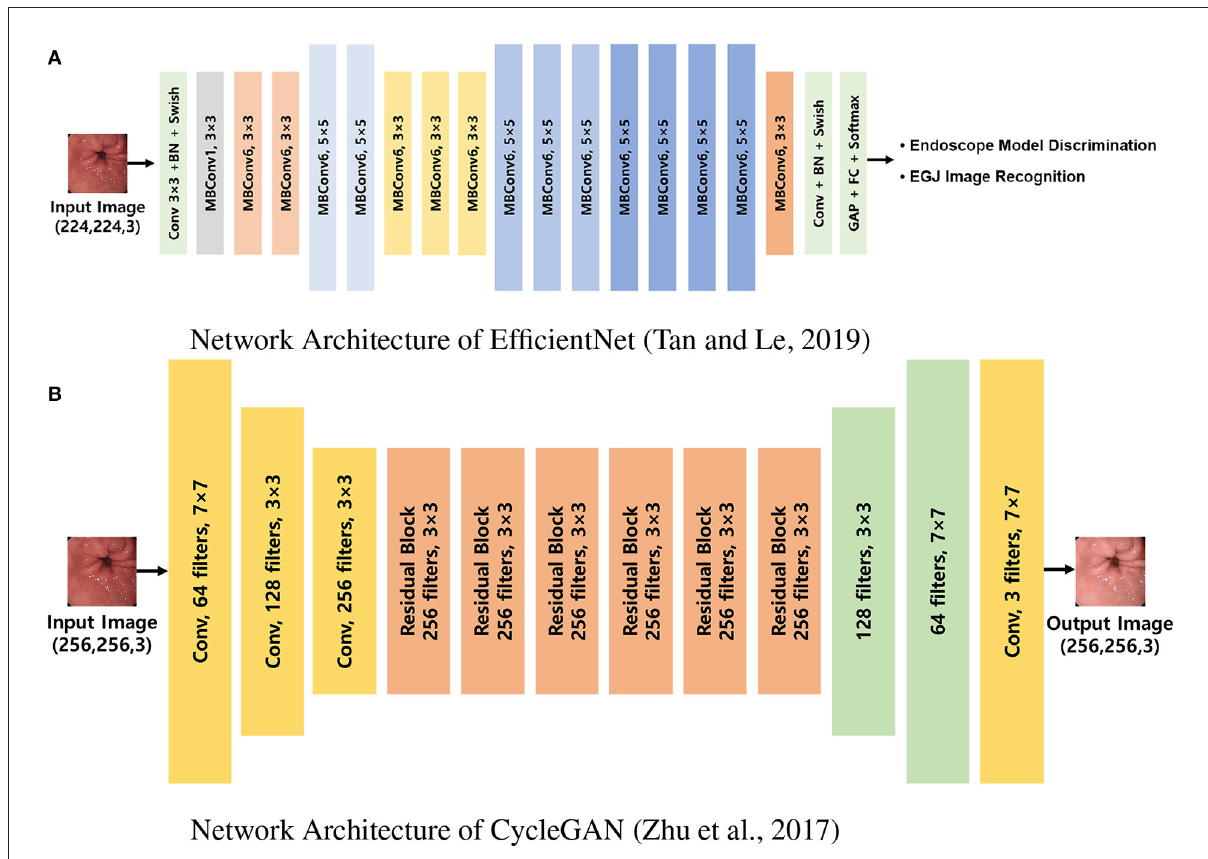
FIGURE2 Network architectures used in the experiments. (A) Network architecture of EfficientNet (12). EfficientNet was trained to discriminate endoscope models and classify EGJ images for each model separately. (B) Network architecture of CycleGAN (9). CycleGAN was trained to transform images from a specific endoscope model to the others. MBConv, inverted linear BottleNeck layer with depth-wise separable convolution; BN, batch normalization; FC, fully connected layer; Conv, convolution; GAP, global average pooling; EGJ, esophagogastric junction; GAN, generative adversarial